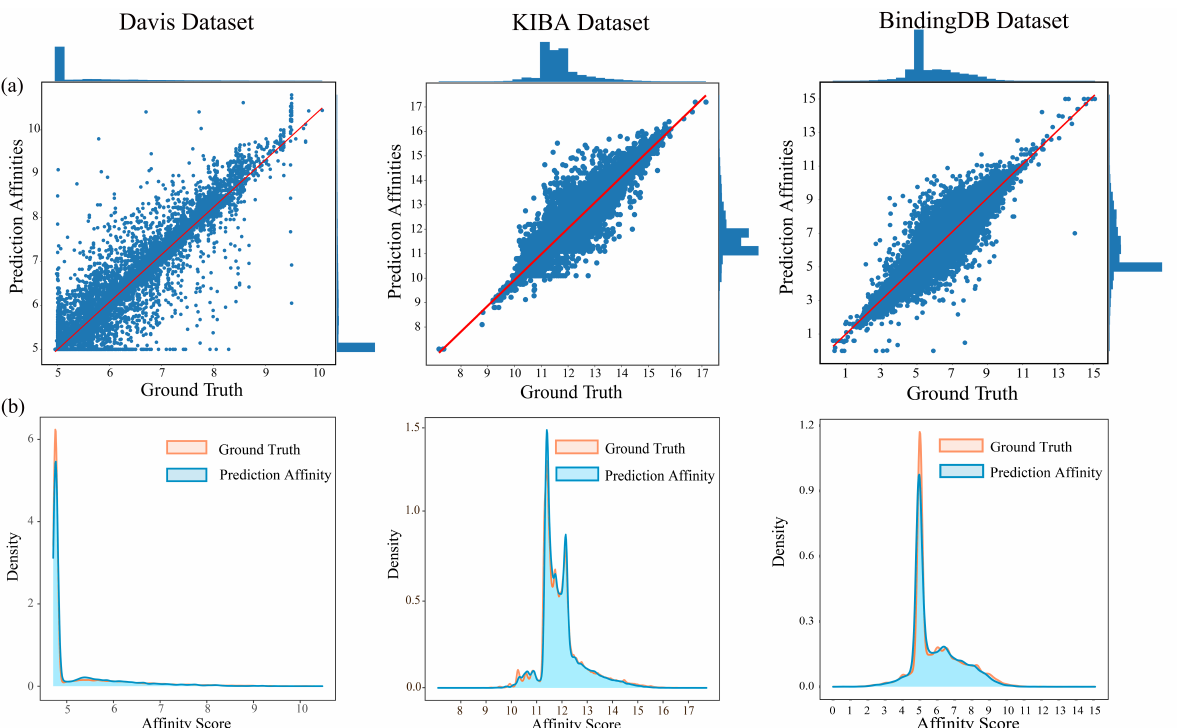
Figure 2. Correlation distribution between ground truths and predictive values on benchmark datasets, ( a ) scatter and ( b ) kernel density estimate